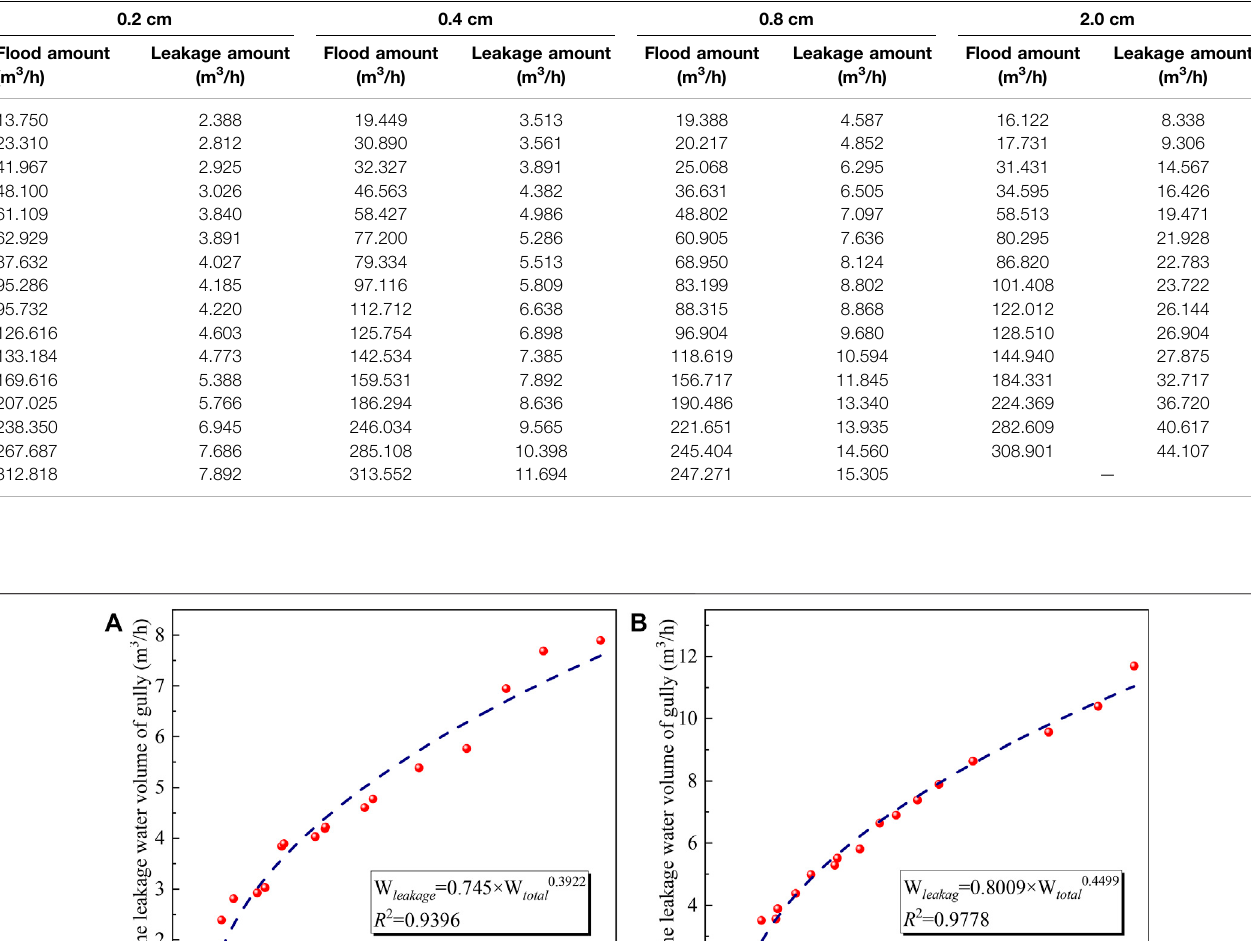
Frontiers in Earth Science |